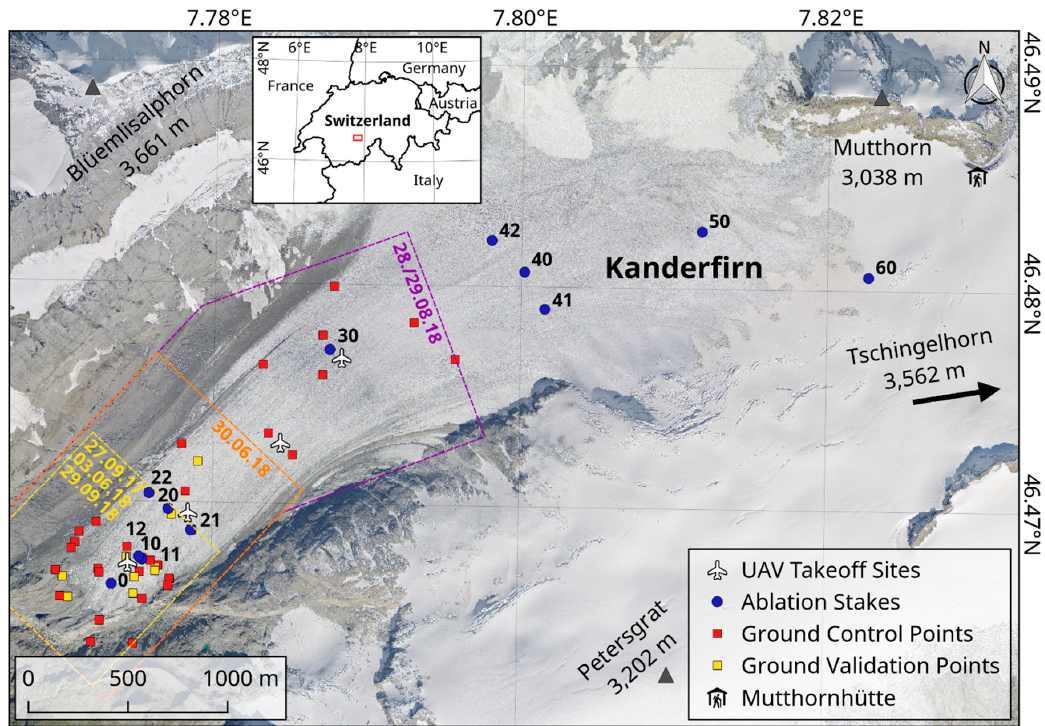
Figure 1. Overview map of the Unmanned Aerial Vehicle (UAV) test site and glacier monitoring network on the Kanderfirn in the Bernese Alps (Switzerland). The dashed outlines (yellow, orange and purple) indicate the spatial coverage of the different UAV surveys in 2017 and 2018. The background image is a high-resolution (25 cm) orthomosaic from 2014 provided by the Swiss Federal Office of Topography.